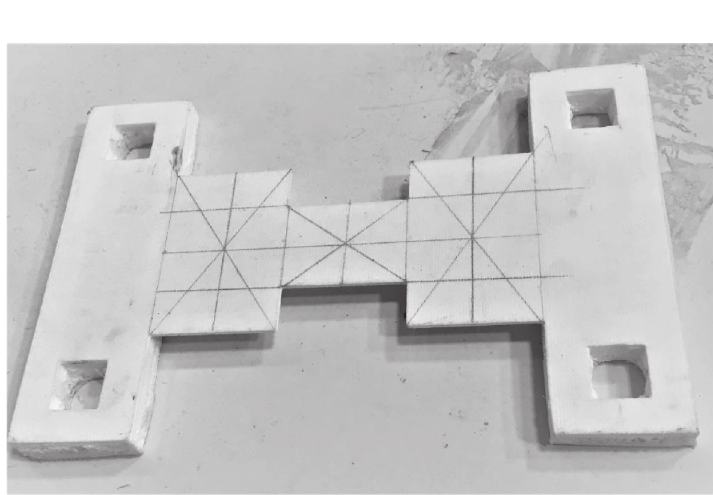
Figure 16: Specimen for experimental modal analysis (Case